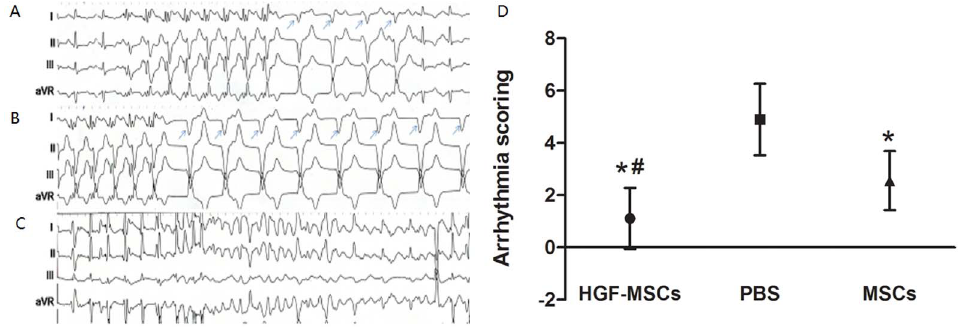
Figure 6. Electrophysiological examination to evaluate the propensity for VA. (A) Induced non-sustained ventricular arrhythmia. (B) Induced sustained ventricular arrhythmia. (C) Ventricular fibrillation evoked by additional stimuli. (D) The susceptibility to developing VA, as indicated by the obtained arrhythmia scores, was lower in the HGF-MSC-treated hearts than in the PBS- and MSC-treated hearts. *, P , 0.05 vs. the PBS group; # , P , 0.05 vs. the MSC group.